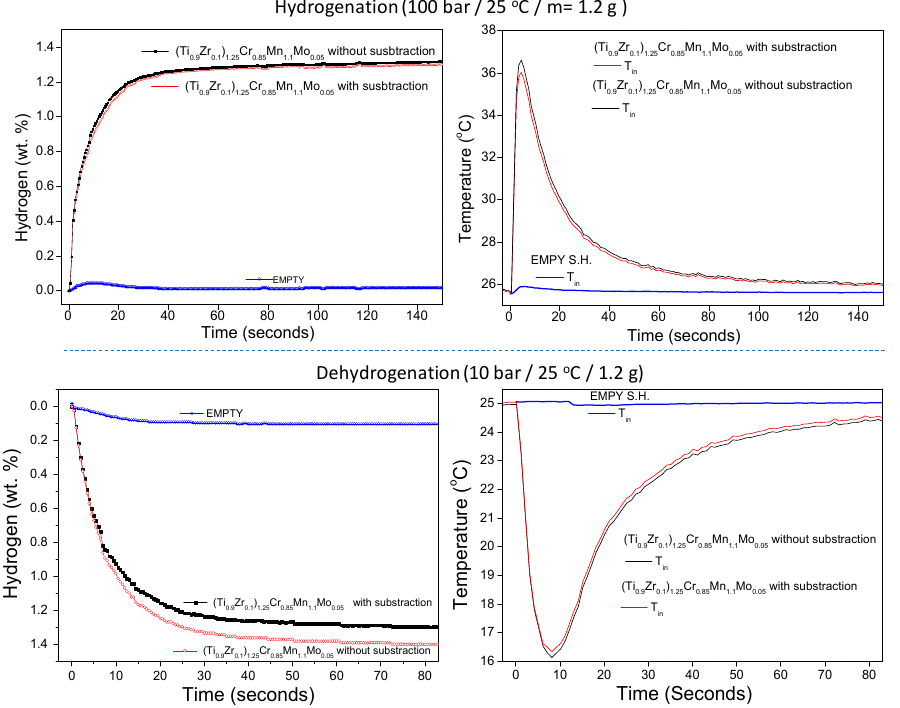
Figure A1. Hydrogenation and dehydrogenation and their temperature profiles curves before and after blank subtraction. Table A2. Cycling conditions for Figure 7. N ◦ of